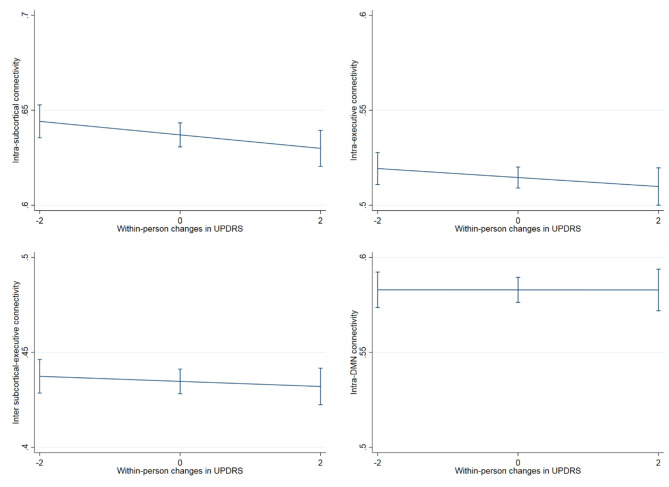
Association between within-person changes in UPDRS scores and functional network connectivity. The figure shows within-person increases in UPDRS scores significantly associated with reduced synchrony of intra-subcortical network connectivity over time (b = −0.0036, p = 0.029), this effect additionally held when subcortical network gray matter volume was adjusted for (b = −0.0035, p = 0.035). On the other hand, the relationship between UPDRS and intra-frontoparietal executive network connectivity and/or inter subcortical- frontoparietal network connectivity did not show significant within-person effects. The presumably unrelated DMN network, was also not significantly associated with UPDRS scores over time.